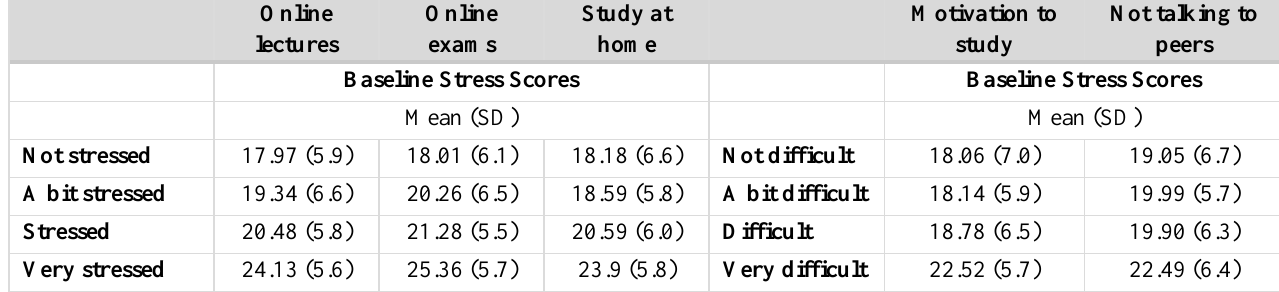
Mean Baseline Stress Scores by Student Responses to Each of the Five Online Learning Questions